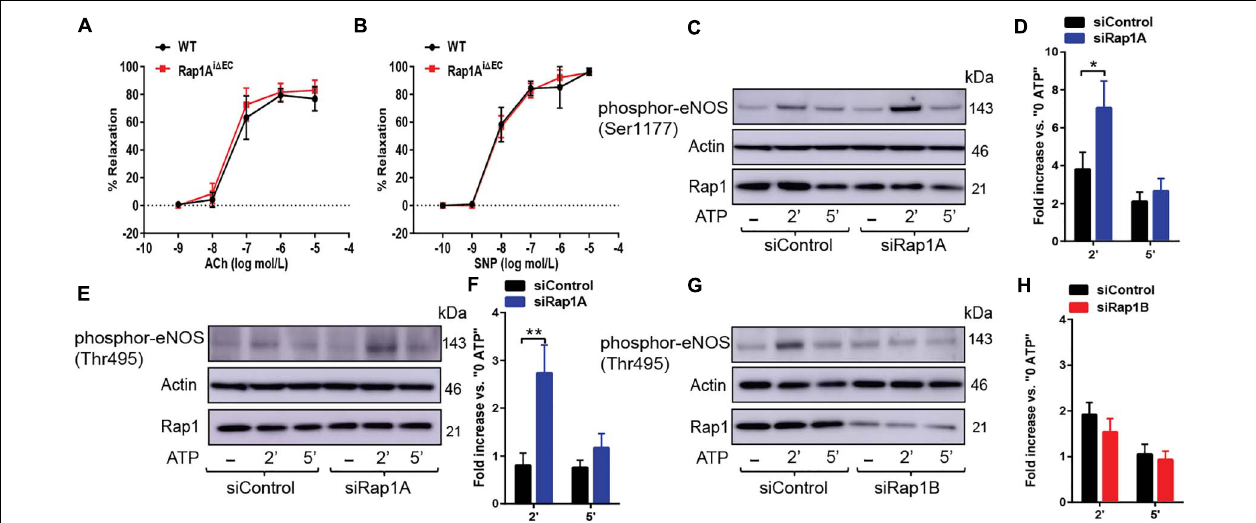
FIGURE 3 | (A,B) Vasorelaxation is not impaired upon EC-deletion of Rap1A isoform alone. Concentration dependent vasorelaxation of phenylephrine-preconstricted aortae from control (WT) and Rap1A i (cid:49) EC mice treated with ACh (A) , and SNP (B) . Values are means ± SEM ( n = 6). (C,D) eNOS Ser1177 phosphorylation is increased in siRap1A ECs. Representative Immunoblot (C) and quantification (D) of fold increase of Ser1177 vs.0 ATP in siControl and siRap1A HCAECs ( n = 6). * indicates p < 0.05 vs. siControl 2’ ATP. One-way ANOVA Tukey’s multiple comparison test was applied to compare statistical significance. (E,F) siRap1A knockdown leads to elevated phosphor-eNOS (Thr-495). Representative Immunoblot (E) and quantification (F) of fold increase of phosphor-eNOS (Thr495) vs.0 ATP in siControl and siRap1A HCAECs ( n = 5). (G,H) siRap1B leads to decreased eNOS Thr-495 phosphorylation. Representative Immunoblot (G) and quantification (H) of fold increase of phosphor-eNOS T(hr495) vs.0 ATP in siControl and siRap1B HCAECs ( n = 5). ** indicates p < 0.01.vs. siControl 2’ ATP. One-way ANOVA Tukey’s multiple comparison test was applied to compare statistical significance.